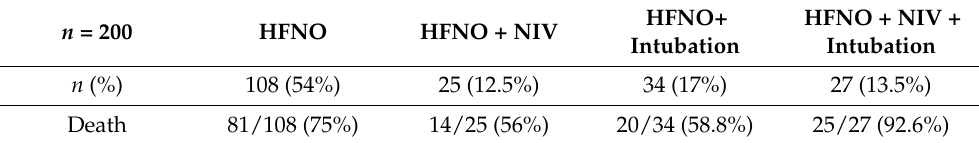
Table 1. Patients ineffectively treated with HFNO.